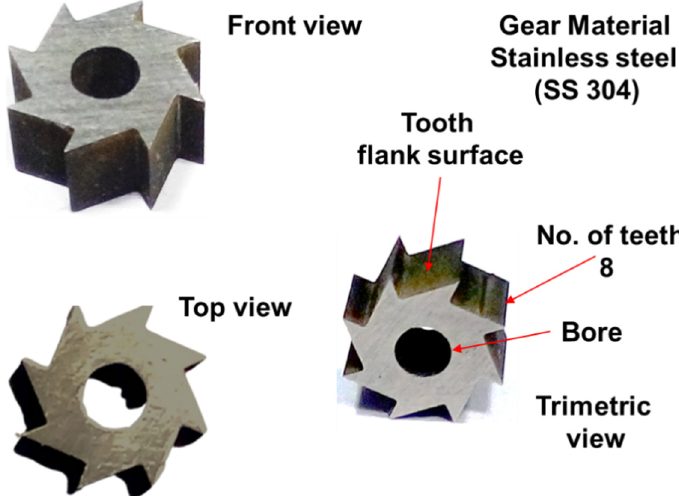
Figure 6. Original pictures of manufactured miniature-sized ratchet wheels made from SS 304 rectangular plate by WEDM process.